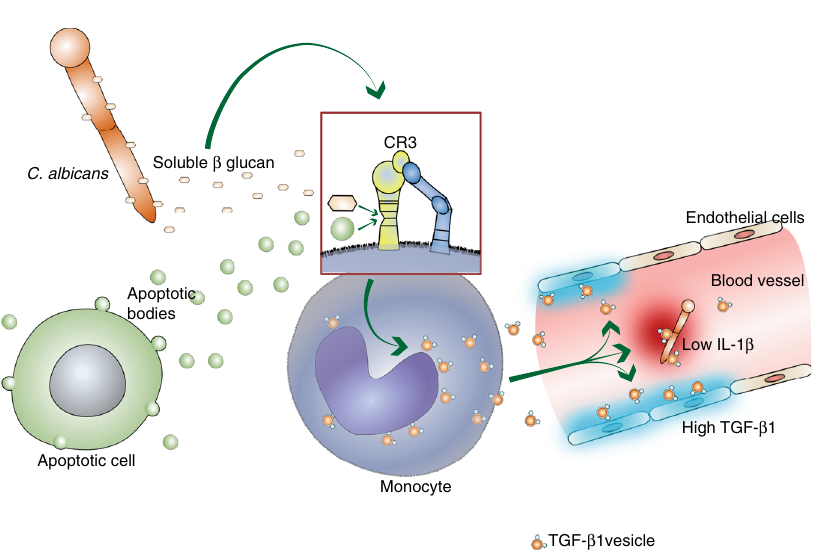
Fig. 7 MEV sCa act anti-in fl ammatory on endothelial cells. a TGF- β 1 vesicles align along the endothelial cells of blood vessels in liver tissue of C. albicans - infected mice as shown by immunohistochemistry as compared with uninfected mice. Liver tissue was collected 24 h after C. albicans infection of mice. Staining – red: TGF- β 1 and orange: nucleic acids. Bars: 10 µ m. Representative stainings of four experiments ( n = 4 mice) are shown. b Tracking of puri fi ed blood cell EVs by DLSM. EVs were isolated from 5 × 10 7 uninfected or opsonized C. albicans -infected blood cells (BCEVs or BCEVs Ca , respectively) by polymer precipitation. Representative pro fi les of three donors are shown. c BCEVs Ca signi fi cantly increase compared with BCEVs (data are presented as mean values + / − SD, p = 0.0031, unpaired two-tailed t test, n = 3 donors). d Pro fi les of BCEVs or BCEVs Ca as determined by DLSM using NanoSight NTA 3.2 software. Graphs were generated by overlaying the size distribution of BCEVs and BCEVs Ca from three donors. e TGF- β 1 is present in the membrane fraction of BCEVs Ca , but not in BCEVs and the cytosol fractions of BCEVs or BCEVs Ca . BCEVs or BCEV CaS were isolated from 5 × 10 7 blood cells, cytosol and membrane fractions separated, and TGF- β 1 detected by western blot (see uncropped WB in Supplementary Fig. 7e). f TGF- β 1 on BCEVs Ca binds to TGF- β RII on HUVECs. HUVECs were incubated with BCEVs or BCEVs Ca for 30 min, stained for TGF- β 1 and TGF- β RII, and TGF- β 1/TGF- β RII complexes were detected by PLA. PLA staining – red: TGF- β 1/TGF- β RII complexes, blue: DNA. Bars: 10 µ m. Representative data of three experiments ( n = 3 donors) are shown in e , f. g HUVECs incubated with BCEVs Ca show increased PLA fl uorescence intensity compared with HUVECs incubated with BCEVs as measured by ZEN Black 2011 software (data are presented as mean values + / − SD, p < 0.0001, unpaired two-tailed t test, n = 32 individual cell from n = 3 donors). h HUVECs treated with BCEVs Ca but not with BCEVs upregulated TGFB1 expression (data are presented as mean values + / − SD, p = 0.0106, unpaired two-tailed t test, n = 5 donors). HUVECs (3 × 10 6 ) were treated for 6 h with BCEVs or BCEVs Ca each isolated from 5 × 10 8 blood cells. Puri fi ed RNA was evaluated by comparative qPCR. i HUVECs treated with BCEVs Ca for 6 h increase intracellular TGF- β 1 as observed in CLSM. Staining – green: TGF- β 1 and orange: nucleic acids. Bars: 10 µ m. Representative data of three independent experiments ( n = 3 donors) are shown. j Intracellular TGF- β 1 as measured by ZEN 2011 (data are presented as mean values + / − SD, p < 0.0001, unpaired two-tailed t test, n = 39 individual cells from n = 3 donors). k BCEV Ca -treated HUVECs increase intracellular TGF- β 1 as measured by ELISA (data are presented as mean values + / − SD, p = 0.0018, unpaired two-tailed t test, n = 4 donors). l HUVECs treated with recombinant TGF- β 1 increase TGFB1 expression in a dose-dependent manner compared to treatment with BCEVs (data are presented as mean values + / − SD, p = 0.0470, p = 0.0213, unpaired two-tailed t test, n = 3 donors). m HUVECs incubated with C. albicans show no increase in TGFB1 expression (data are presented as mean values + / − SD, p = 0.9839, unpaired two-tailed t test, n = 3 donors).